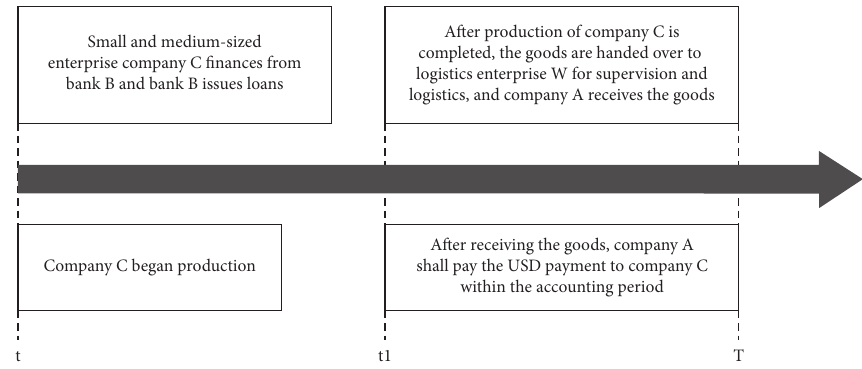
Figure 1: Business process of order financing based on foreign currency